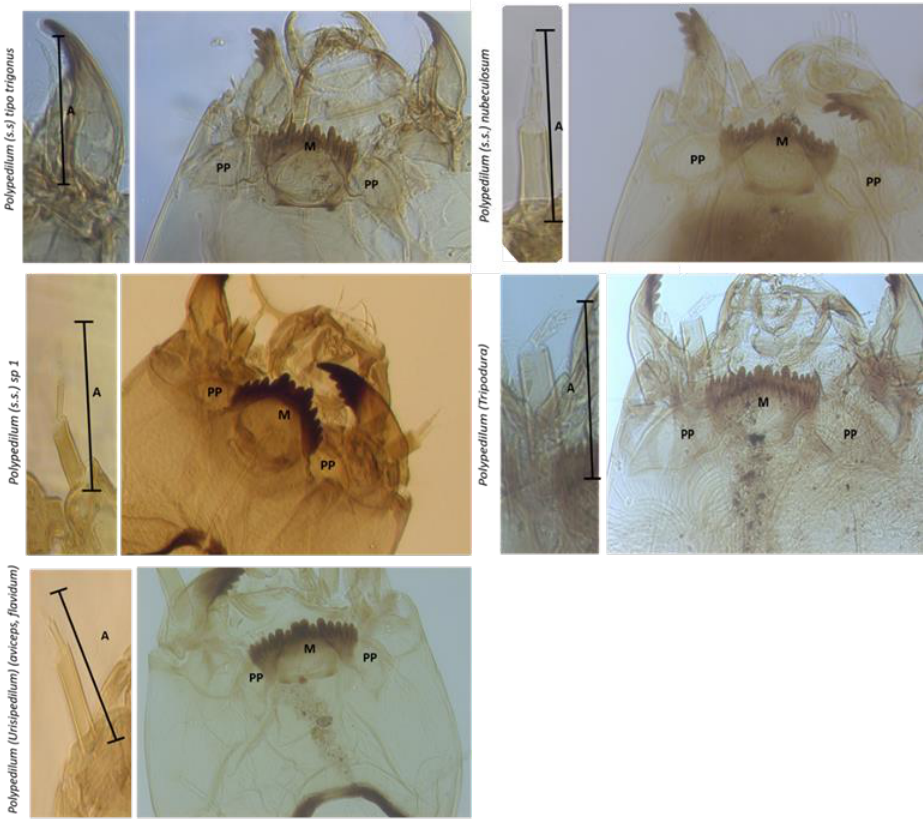
Figure 3. Polypedilum morphotypes in El Oro. A: Antenna; M: Mentum; PP: Paralabial plates. The ABGD method produced the same results for the JC69 and K2P models. The frequency histogram of pairwise distances indicated a clear barcode gap between 0.01 and 0.12 (Figure 4A). This method produced one initial partition and 12 OTUs ( p = 0.01 to 0.077), while the recursive partition generated from 25 ( p = 0.005) to 13 ( p = 0.044)